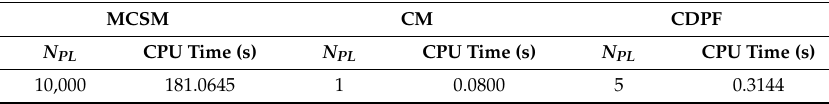
Table 3. CPU time and calculation number N PL of the DPF.